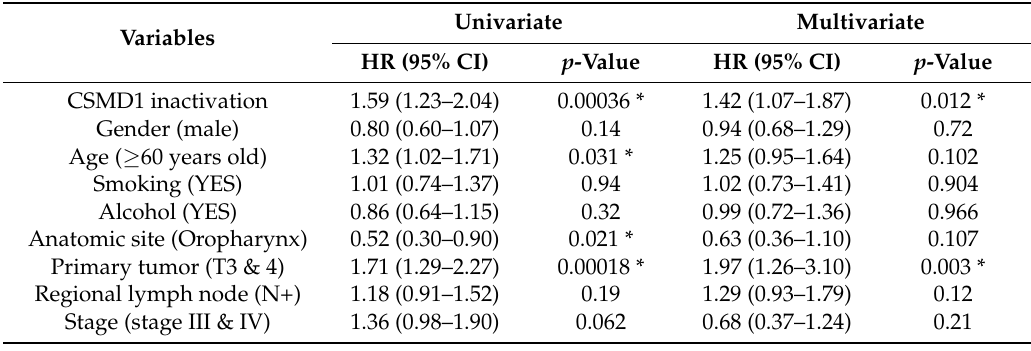
Table 2. Univariate and multivariate Cox proportional hazard regression analysis of overall survival in the TCGA and Leipzig cohorts ( n = 712).